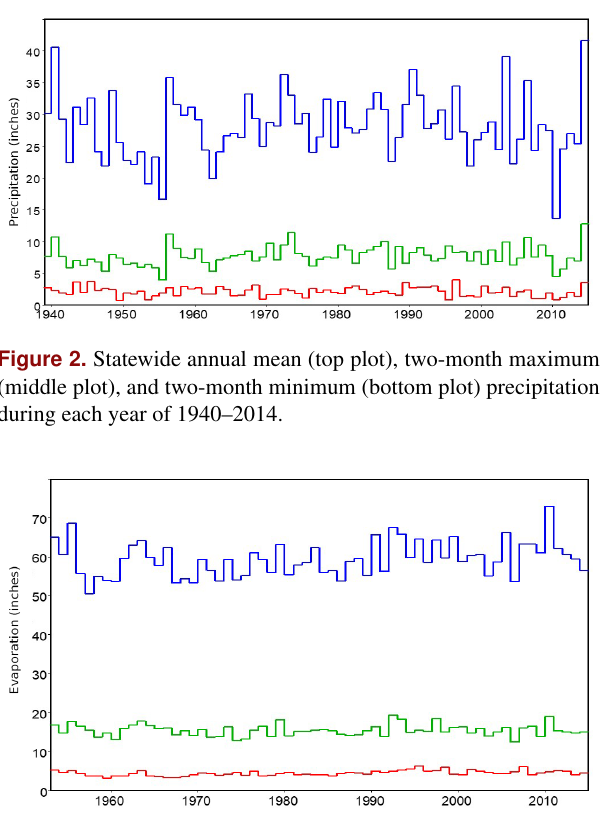
Figure 3. Statewide annual mean (top plot), two-month maximum (middle plot), and two-month minimum (bottom plot) reservoir evaporation rates during each year of